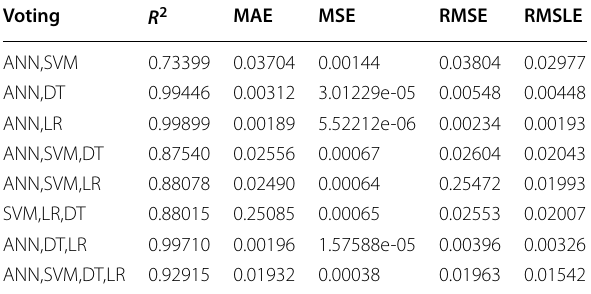
Table 5 Prediction performance of voting approach type of ensemble